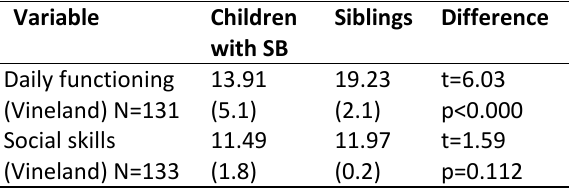
Table 3. Vineland Adaptive Behaviour Daily Functioning and Social Skills Subscale Outcomes for children with spi- na bifida and siblings in Uganda (means, SD, and